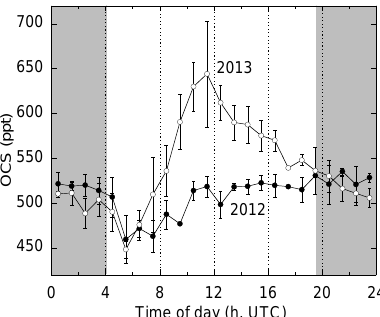
Figure 4. Mean diel patterns in ambient OCS mixing ratios at the O3HP site in June of 2012 and 2013 (displayed with dots and cir- cles, respectively). The timescale is UTC time and the grey verti- cal bands correspond to nighttime. Error bars represent one stan- dard deviation of hourly mean OCS mixing ratios recorded consec- utively by the gas chromatograph for several days. Full records are displayed in Figs. 2c and 3b,